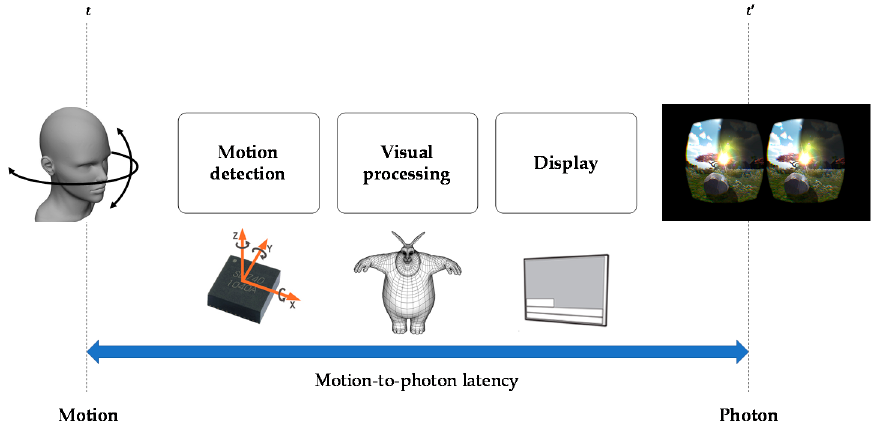
Figure 1. Image generation process in the HMD (head-mounted display) system.